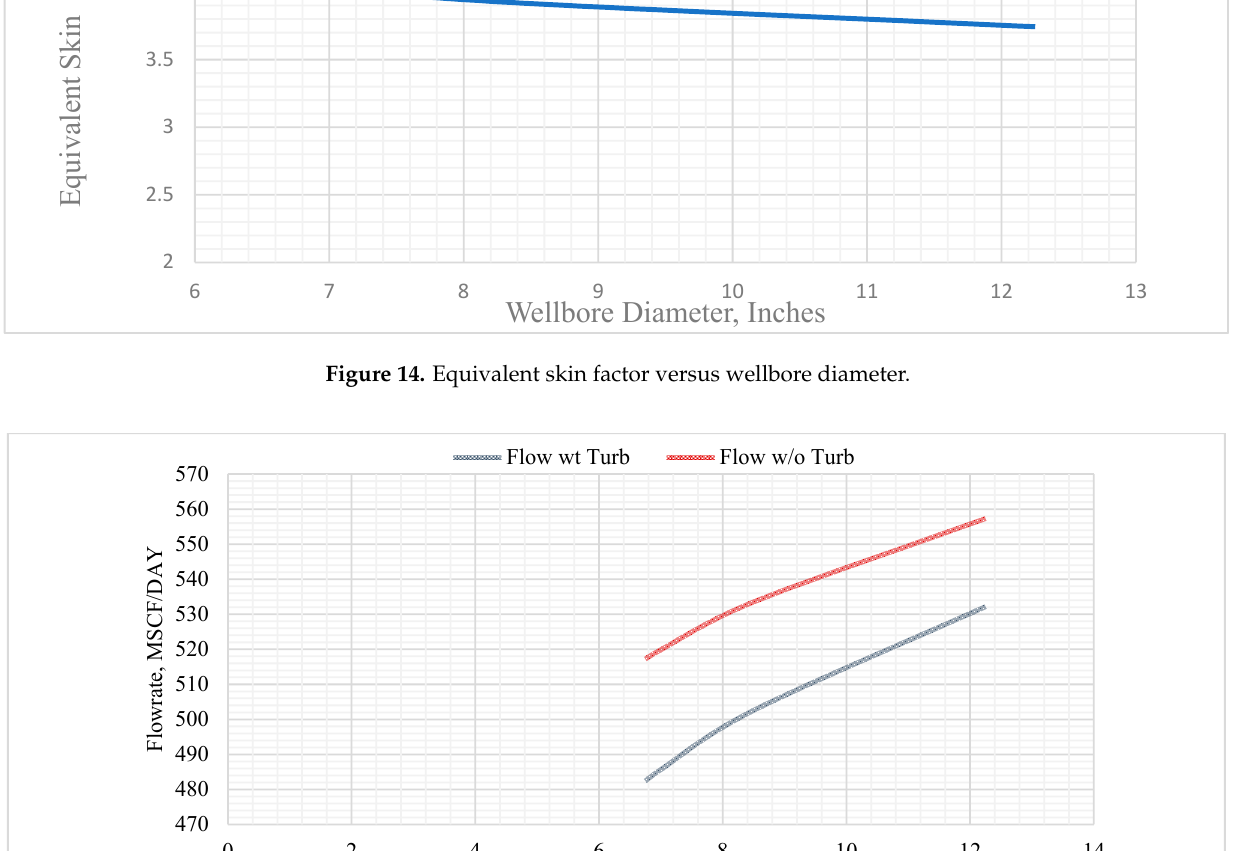
Figure 15. Gas flow rate versus wellbore diameter.